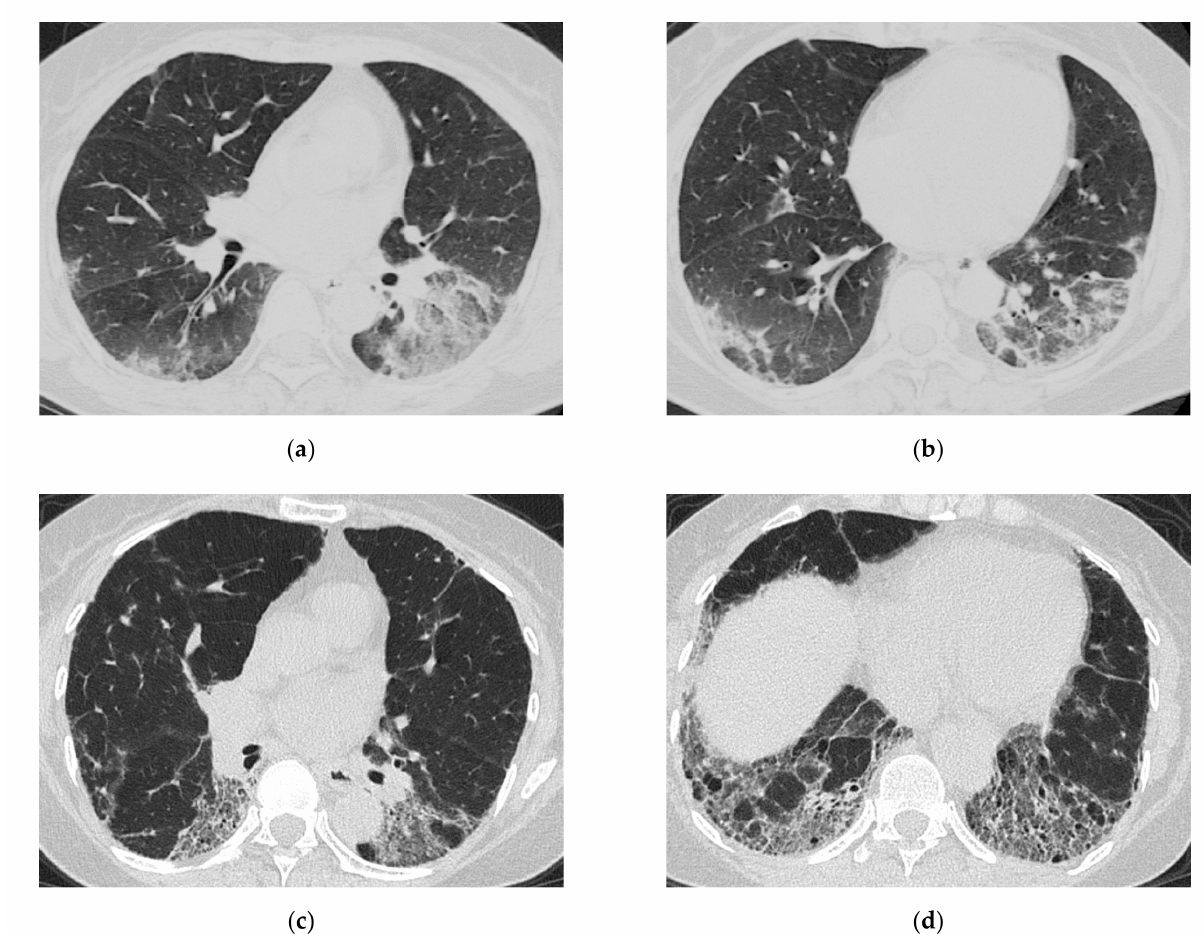
Figure 8. A 64-year-old woman with subacute onset interstitial lung disease associated with polymyositis. At the time of initial diagnosis ( a , b ), there was bilateral consolidation to ground-glass opacification with lower and peribronchovascular predominance. Then, 13 years later ( c , d ), the lesion became less extensive, and the lesion had changed into reticulation with traction bronchiectasis. Decreased lung volume of the lower lobes was visible.